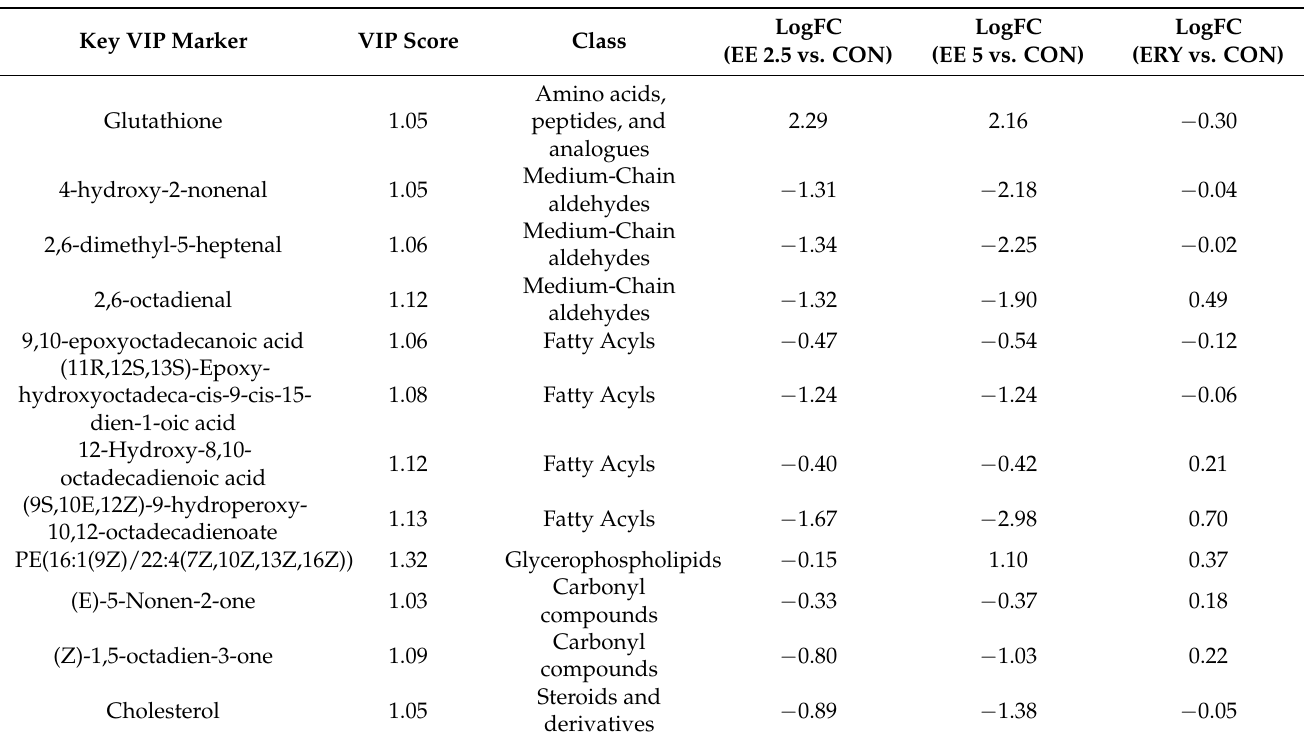
Table 2. Key VIP marker compounds at T13 of the storage period (as related to lipid and protein oxidation events). Each VIP discriminant marker is followed by a VIP score, chemical class, and Log Fold-Change (FC) for the comparison against the control sample